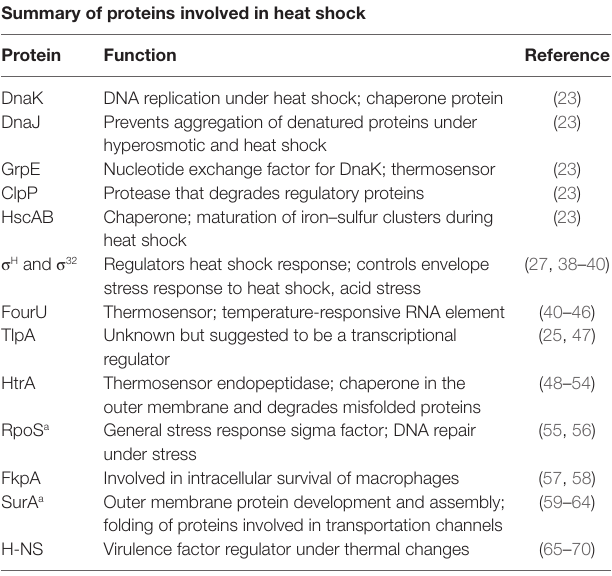
TAbLe 1 | Proteins involved in heat shock and their function are described. Summary of proteins involved in heat